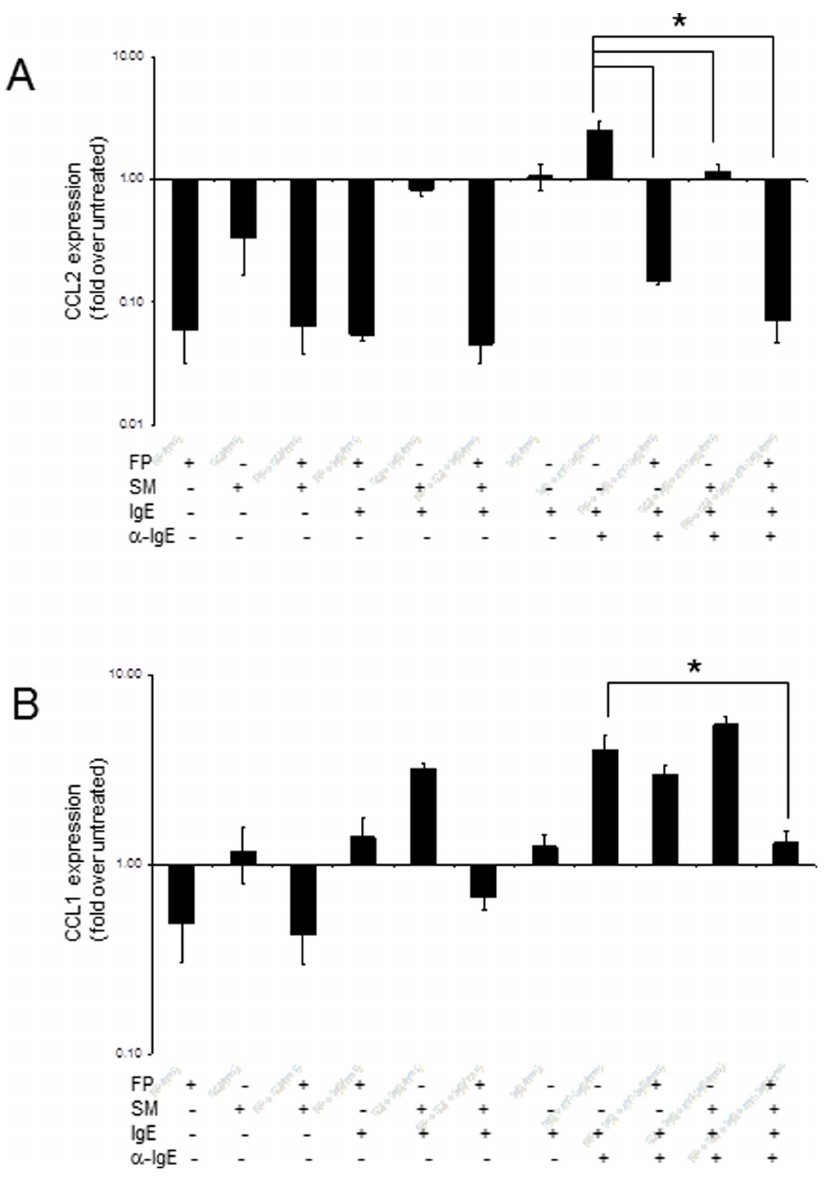
Figure 5. Fluticasone and salmeterol inhibit Fc e RI-mediated production of chemokines. A , LAD2 human mast cells were sensitized with human myeloma IgE (0.5 ug/mL) for 16 hr, then treated with fluticasone (1 uM) or salmeterol (1 uM) or in combination for 20 hr and stimulated with anti-IgE (100 ug/mL) for 3 hr and CCL2 and CCL1 ( A and B respectively) expression was measured by quantitative PCR (n=6, *=p , 0.01 compared to untreated control, unless otherwise